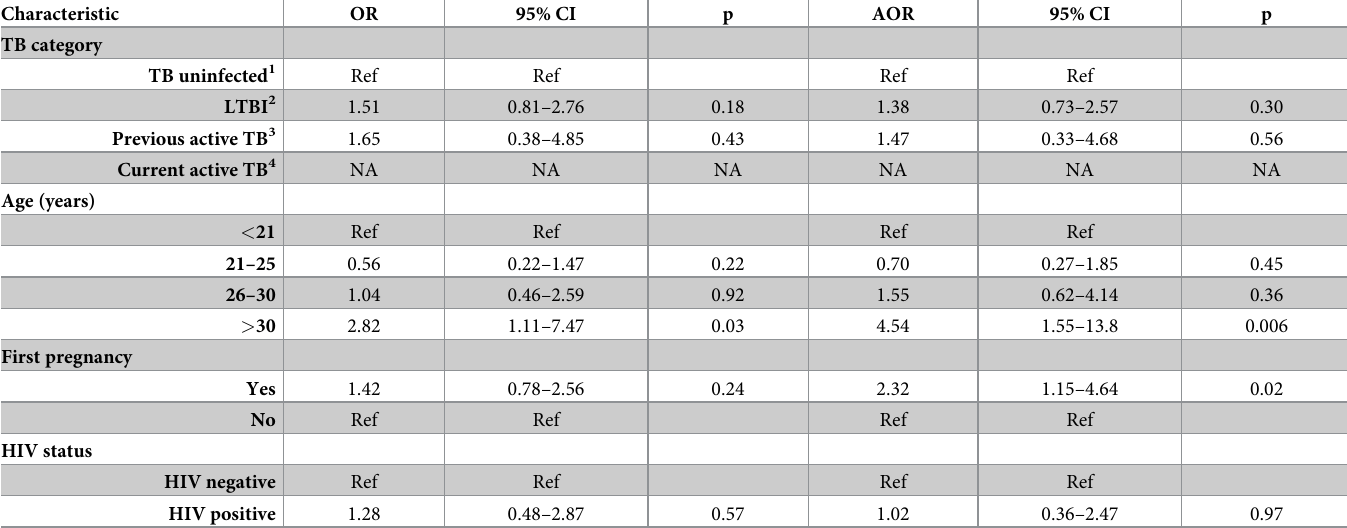
Table 3. Crude and adjusted odds ratios for stillbirth ( � 20 weeks of gestation) with respect to maternal TB infection category, maternal age, gravidity and HIV- status.